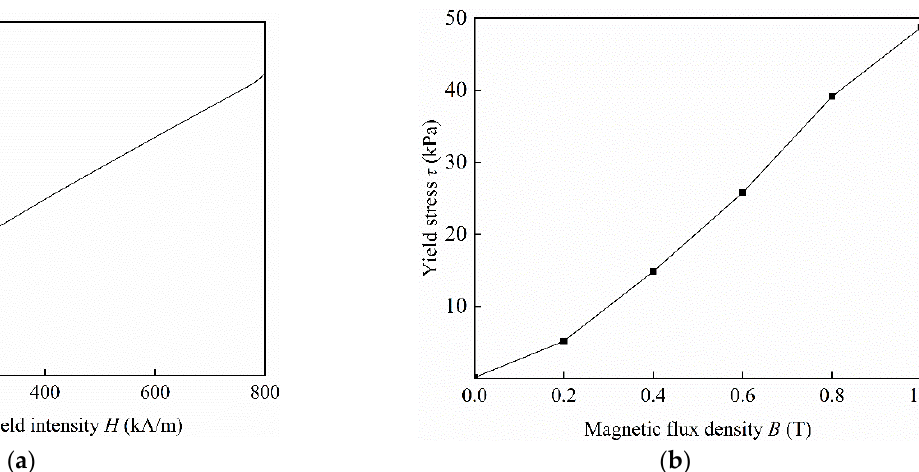
Figure 3. Magnetization curve of No. 10 steel.